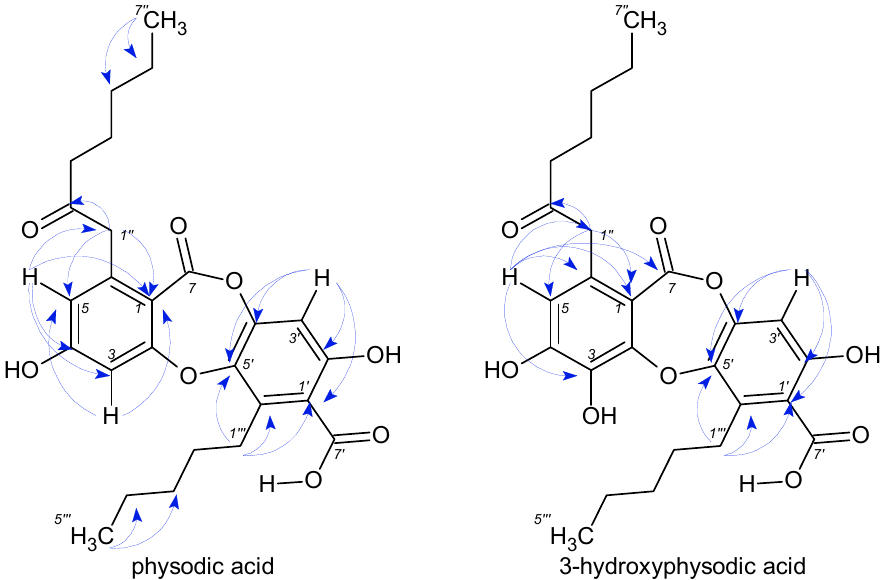
Figure 2. Chemical structures of depsides, physodic, and 3-hydroxyphysodic acid along with their key HMBC correlations.